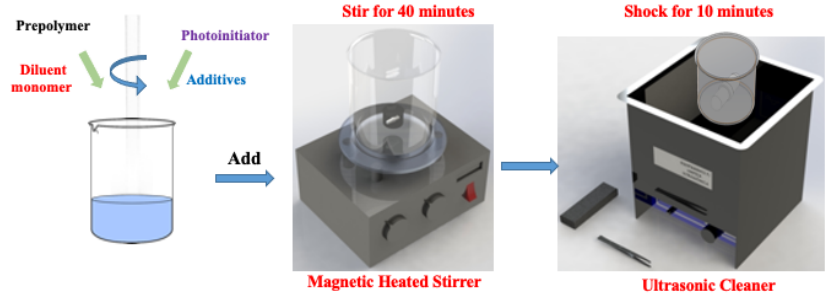
Figure 1. Resin slurry configuration process.